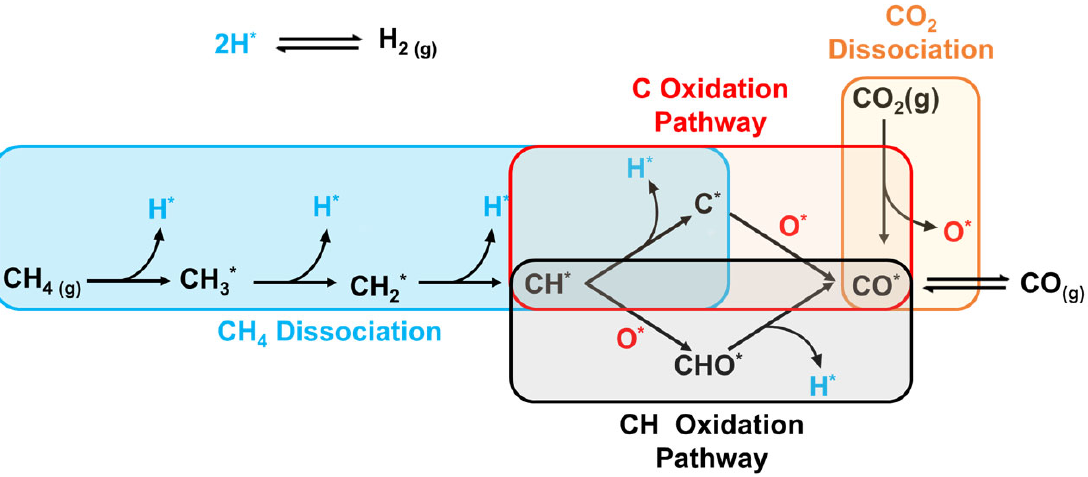
Figure 13. Reaction mechanism of dry reforming of methane (DRM) pathways. Reprinted with permission from Ref. [123]. Copyright 2014 Elsevier.